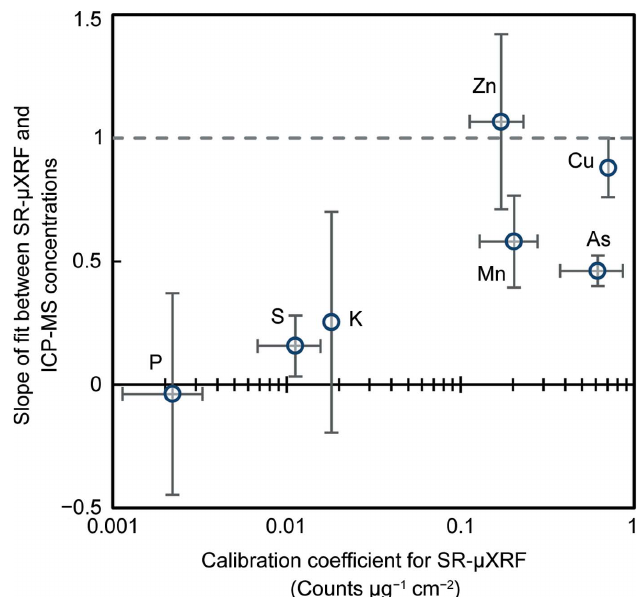
Figure 6 Comparison of SR- m XRFaccuracy against the sensitivity of SR- m XRF for selected elements, showing that SR- m XRF is low for elements when SR- m XRF sensitivity is low. The dashed line is the ideal slope of unity, indicating 1:1 agreement between SR- m XRFand ICP-MS concentrations. Error bars in the x direction denote the range ( n = 2) in SR- m XRF sensitivity between synchrotron experiments when available. For the y axis, the error bars are the 95% confidence intervals for the